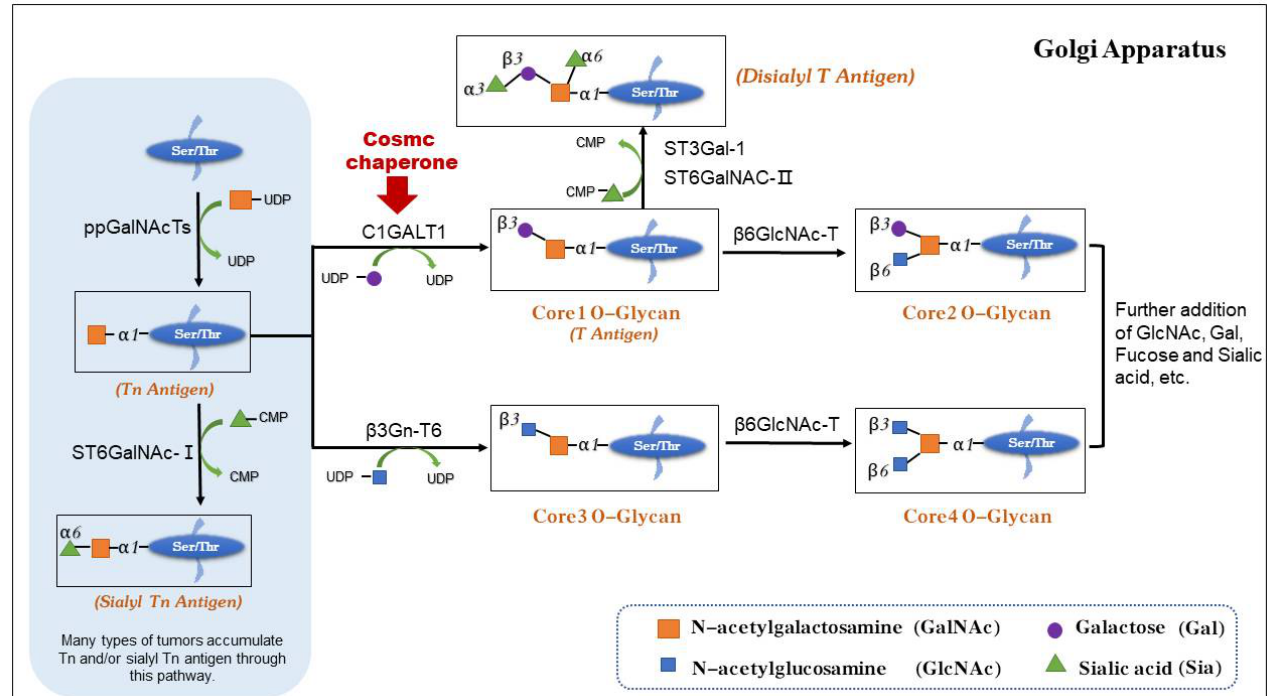
Figure 1. Schematic diagram of the biosynthesis of O-glycan. O-glycosylation is normally initiated in the Golgi apparatus. With the assistance of the molecular chaperone Cosmc, C1GALT1 adds Gal from UDP-Gal to the Tn antigen to form the T antigen, which is extended by adding other sugars to produce normal O-glycans. Without Cosmc, the function of C1GALT1 would be lost, resulting in the generation of Tn and/or Sialyl Tn antigen, which is usually associated with the molecular mechanisms of the development of various diseases or tumors.